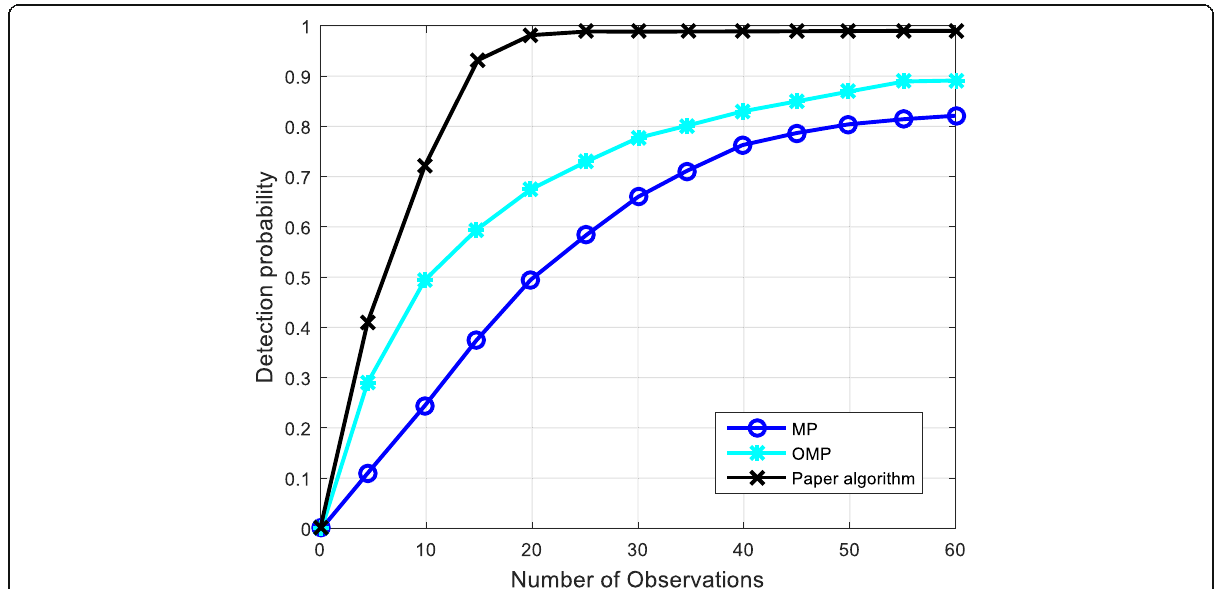
Fig. 4 The curve of the relationship between observed values and detection probability. This result in Fig. 4 indicates that the spectrum sensing performance of the MP algorithm and the OMP algorithm is gradually improved when the number of observation points of the compressed sensing is increased. This is because that the more sampled values, the more information is obtained. Besides, the MP algorithm and the OMP algorithm are algorithms for a single task, regardless of the spatial diversity information, and the only information available is from the compressed sensing observations. Compared with the MP and OMP algorithms, the proposed algorithm has no change in the ROC curve when the number of observation is greater than 20 and the detection probability approaches 1. Because it makes full use of the compressed sensing data information collected by each SU and the number of iterations of the algorithm is not related to the number of samples. Even at lower sample values, it can still obtain batter detection performance and effectively reduce the system overhead of spectrum sensing. From the ROC of the three algorithms and considering the lower number of observation, it is obvious that the correct detection probability of the paper algorithm is better than the MP and OMP algorithms, and the spectrum sensing performance is